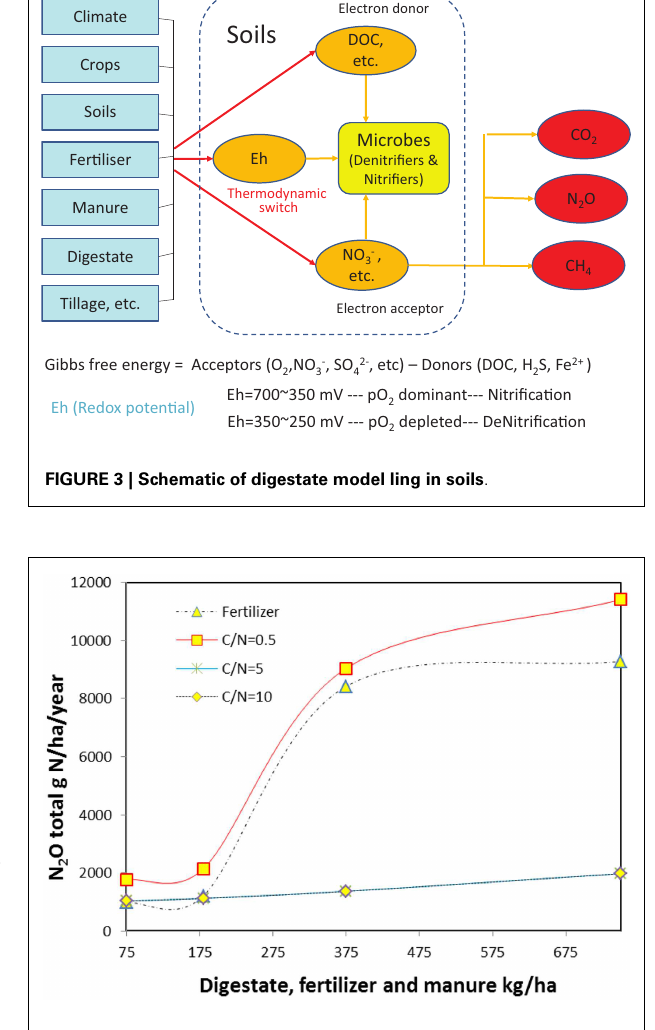
FIGURE 4 |A comparison of N 2 O emissions among fertilizer, digestate, and manure